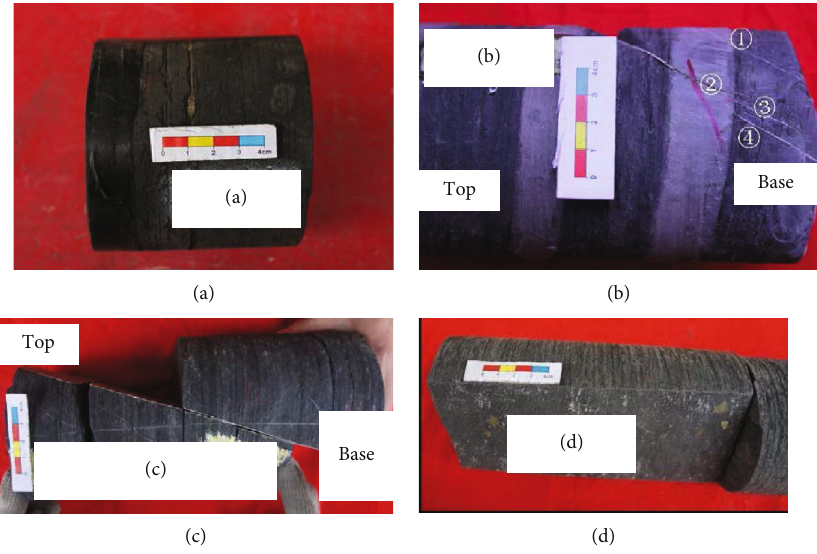
Figure 11: Fractures in the cores from Longmaxi Formation [48].